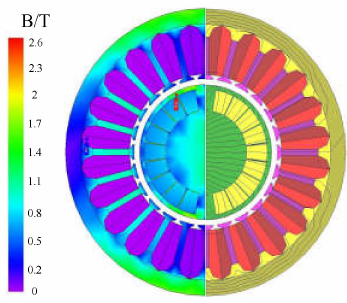
Figure 4. Motor magnetic field distribution during no-load operation.